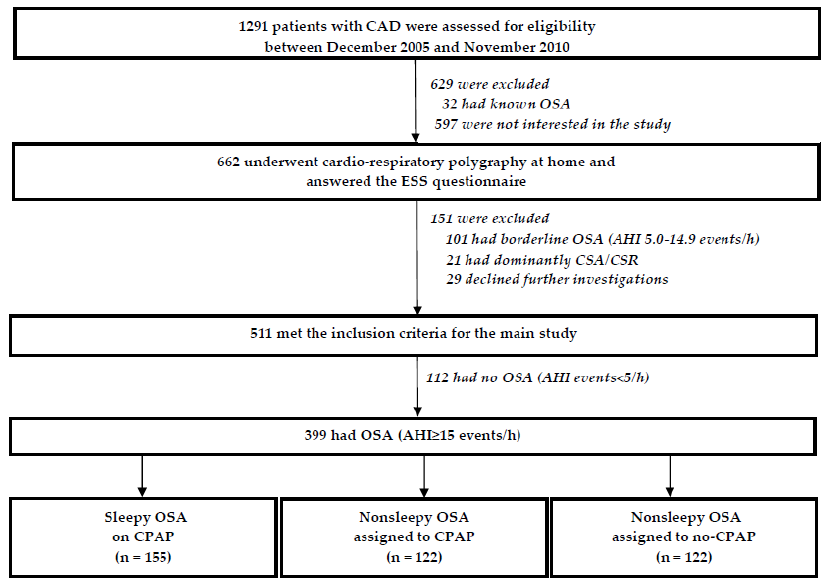
Figure 1. Flow ‐ chart of the study population. AHI, apnea–hypopnea index; CAD; coro ‐ Figure 1. Flow-chart of the study population. AHI, apnea–hypopnea index; CAD; coronary artery nary artery disease; CPAP, continuous positive airway pressure; CSA ‐ CSR, central sleep disease; CPAP, continuous positive airway pressure; CSA-CSR, central sleep apnea–Cheyne Stokes apnea–Cheyne Stokes respiration; ESS, Epworth Sleepiness Scale; OSA, obstructive sleep respiration; ESS, Epworth Sleepiness Scale; OSA, obstructive sleep